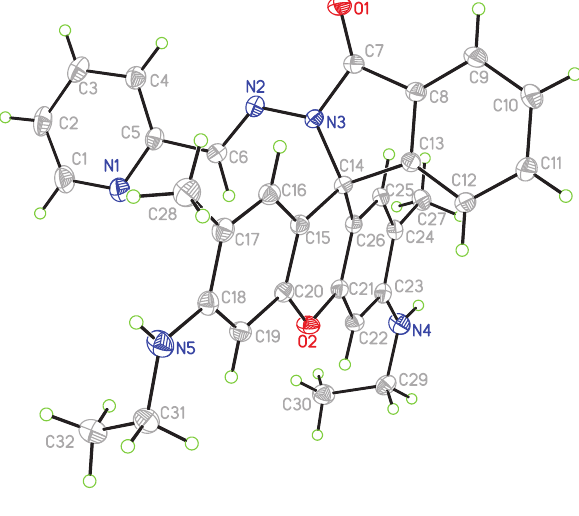
Table 1: Data collection and handling.